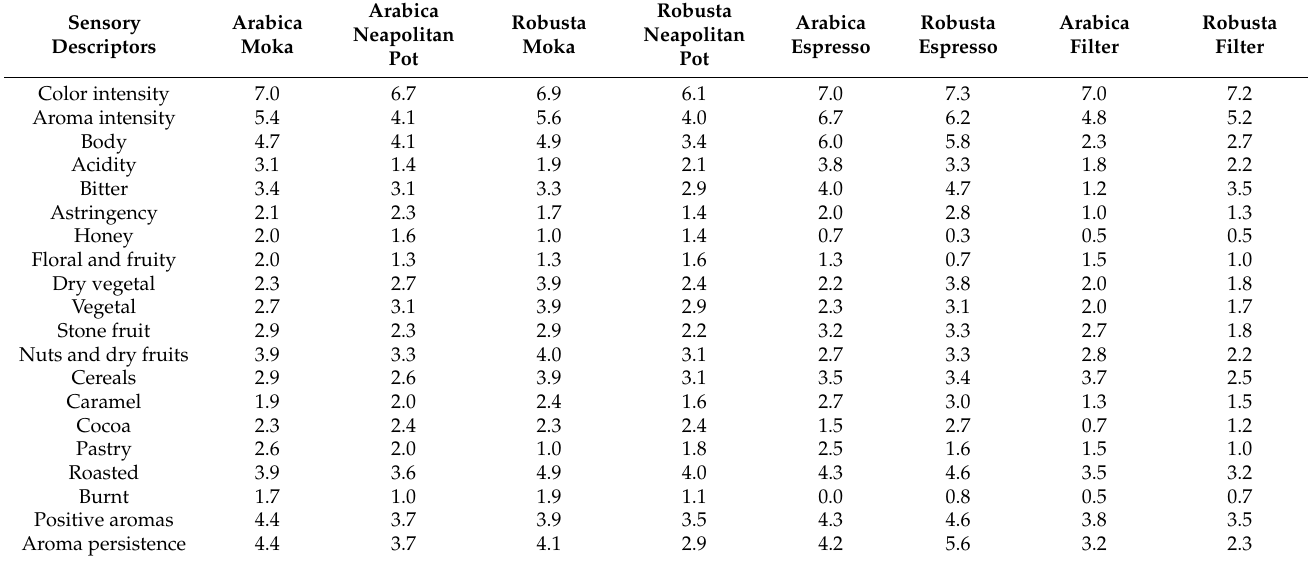
Table 2. Median values of sensory descriptors for different coffee beverages corresponding to four extraction systems applied on Arabica and Robusta roasted coffee. The meaning of each descriptor was explained to the panelist according to World Coffee Research